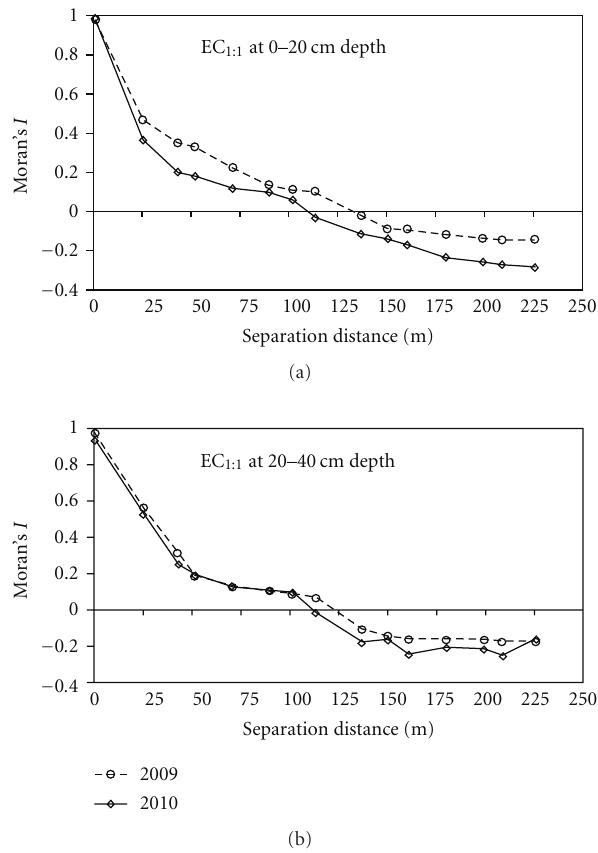
Figure 6: Spatial autocorrelation, Moran’s I of soil EC 1:1 for 0–20 and 20–40 cm depth during 2009 and